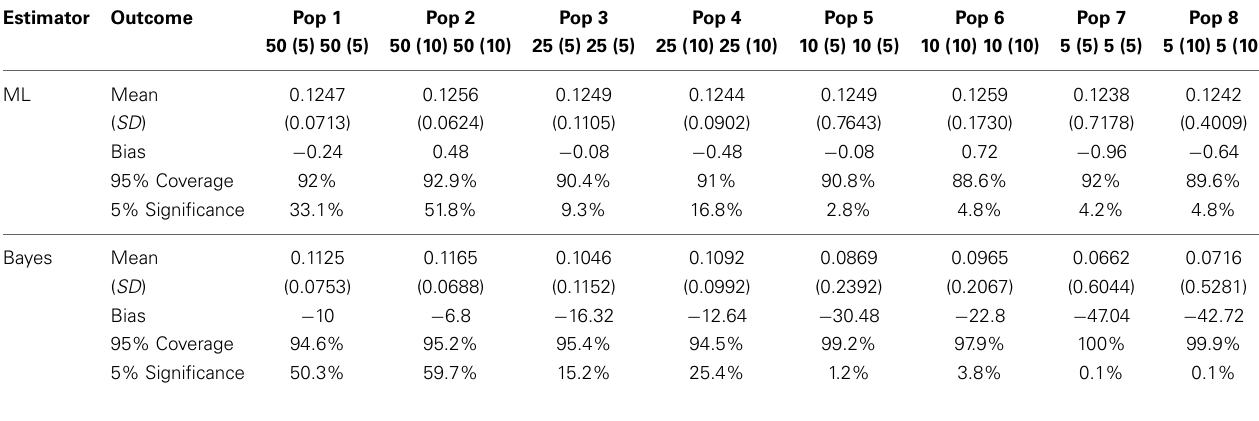
Table 1 | Simulation study results for the eight populations using Maximum Likelihood and Bayes. Estimator Outcome